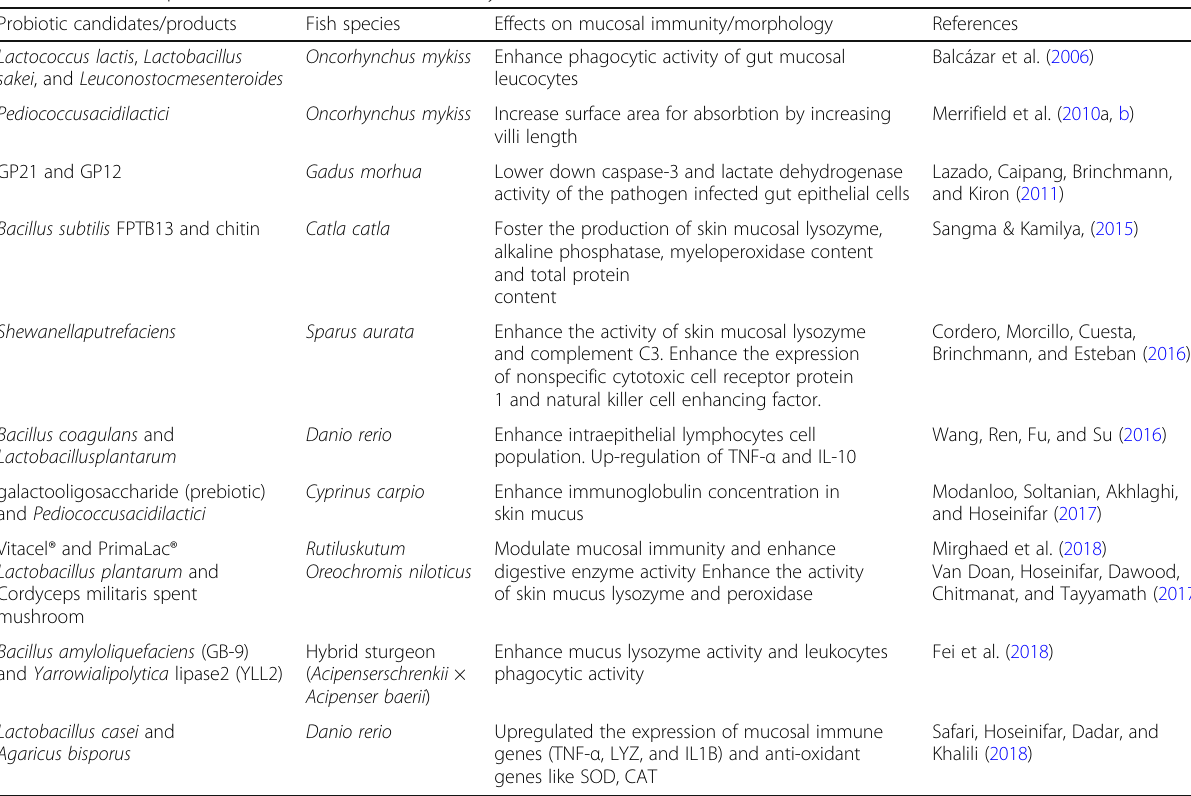
Table 7 Effects of probiotics on fish mucosal immunity Probiotic candidates/products Fish species